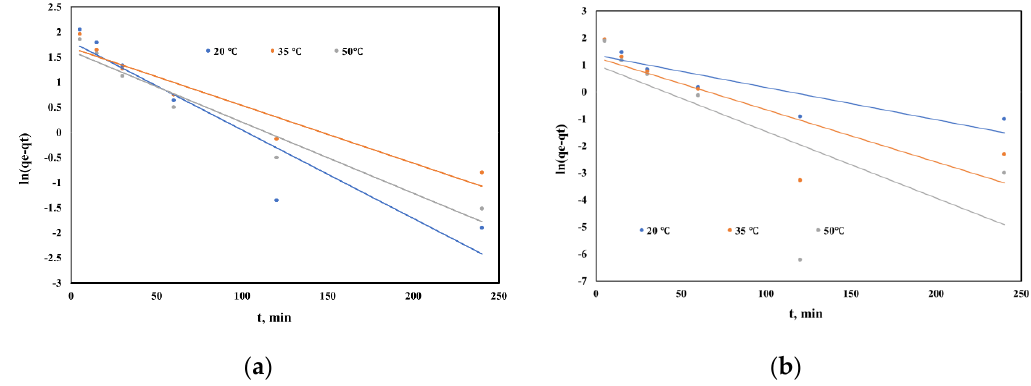
Figure 6. Pseudo-first-order kinetic model of MoO 42− adsorption onto ( a ) Mg 4 Fe and ( b ) Mg 4 Fe-450.